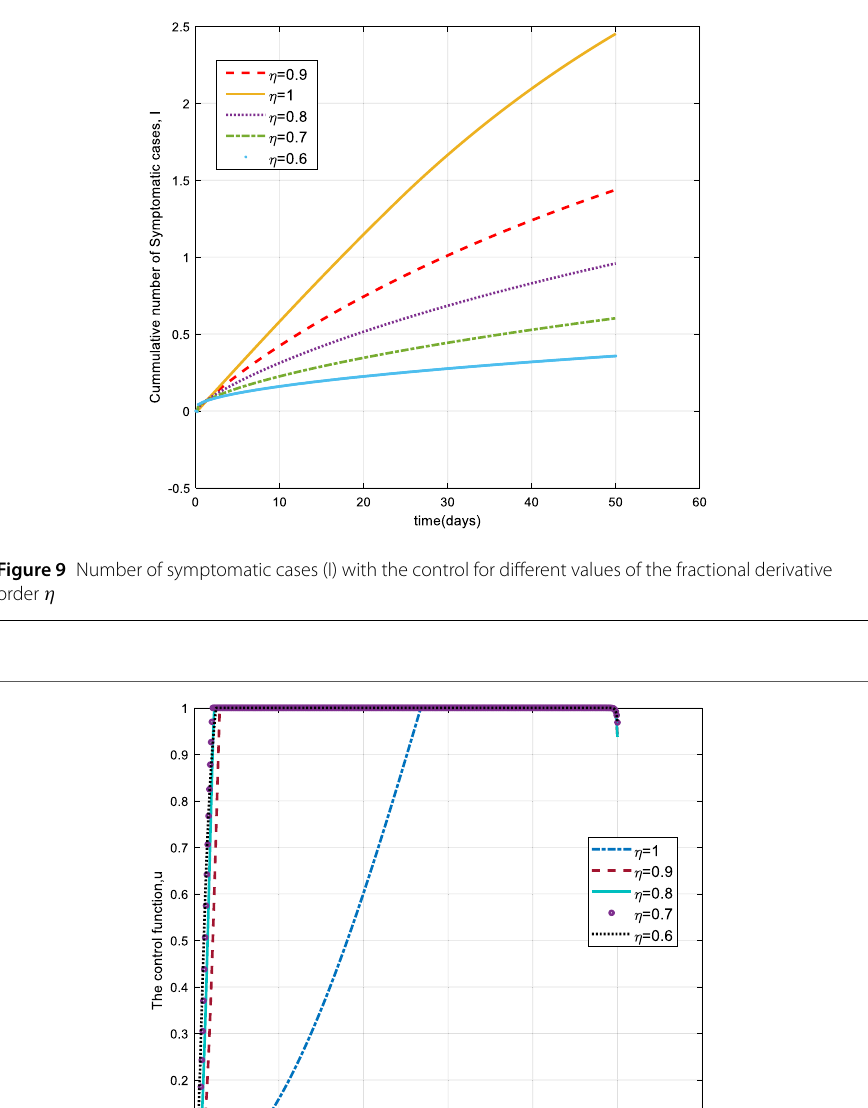
the result obtained in this study for the SEAIR model by using the Atangana–Baleanu fractional operator with results that could be obtained by applying the other fractional operators for the same model can be a gap for future